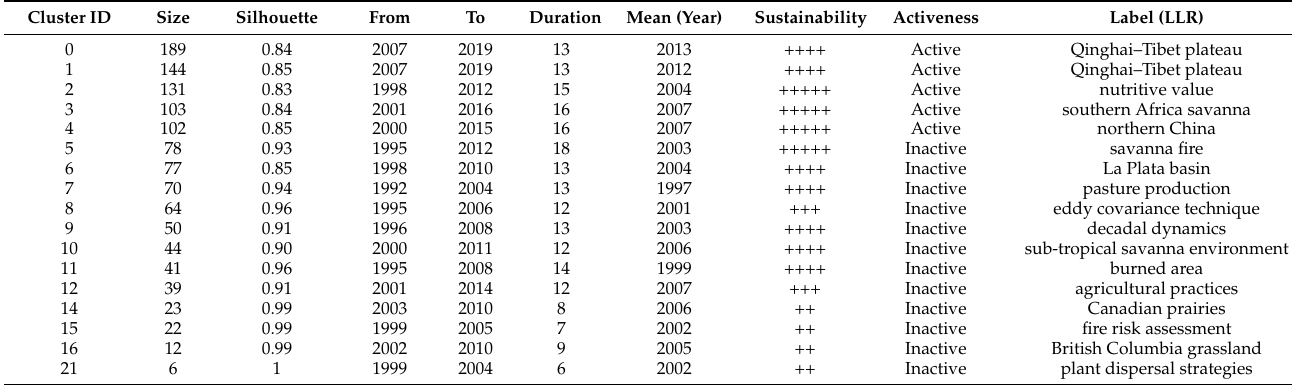
Table 7. Temporal properties of all